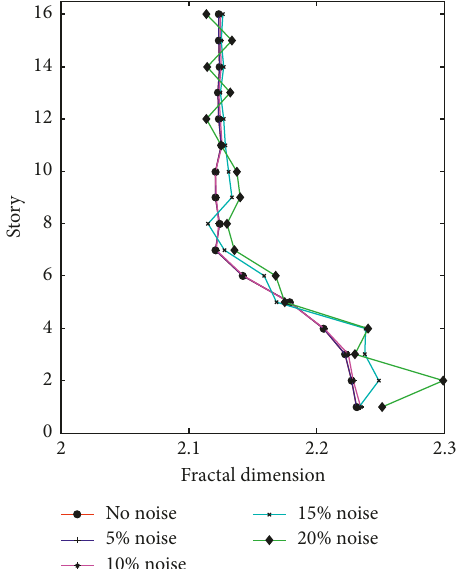
Figure 23: FDs of the TFFs of interstory displacements under different noise levels (Case 5).